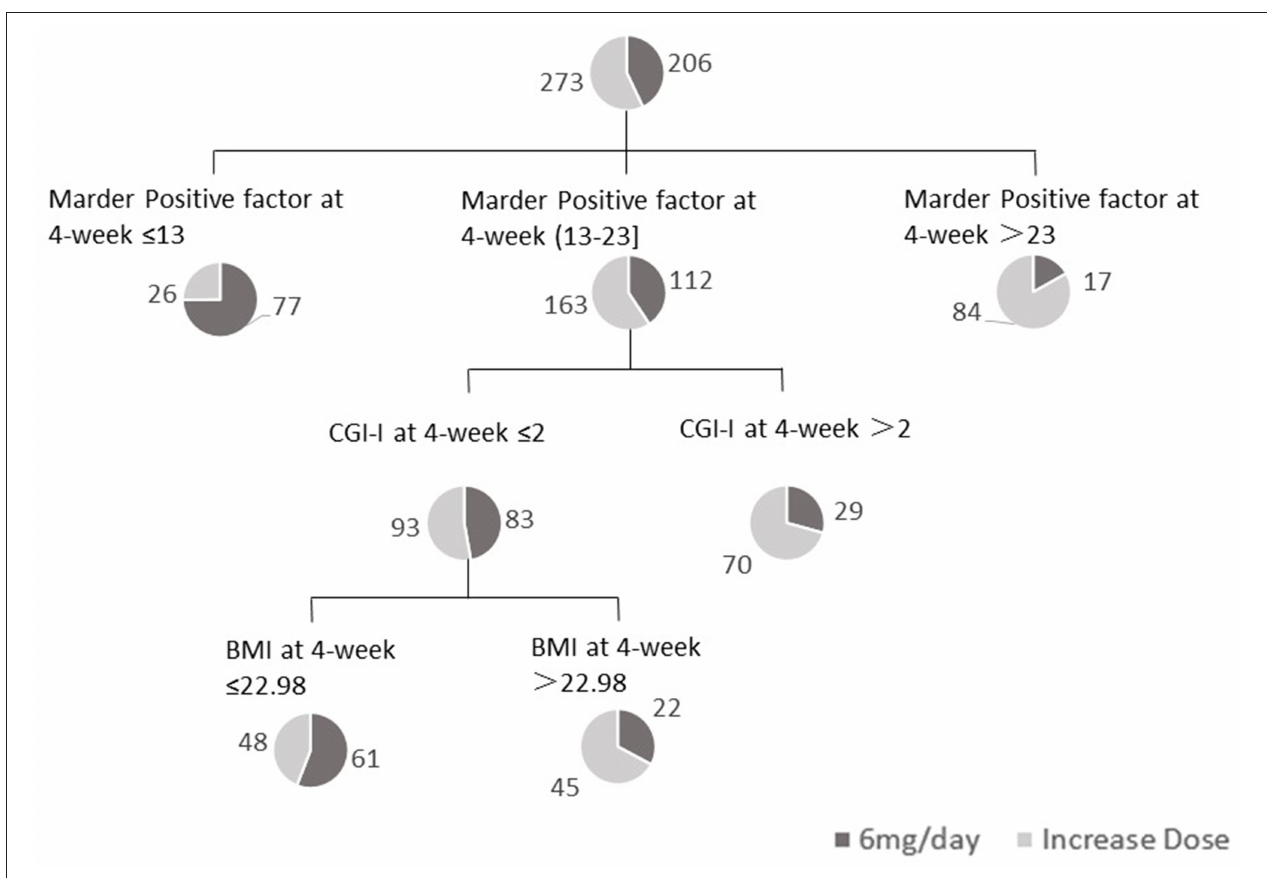
FIGURE 1 | A decision tree for the prediction of paliperidone ER dose increase. CGI-I, Clinical Global Impression-Improvement; BMI, body mass index.